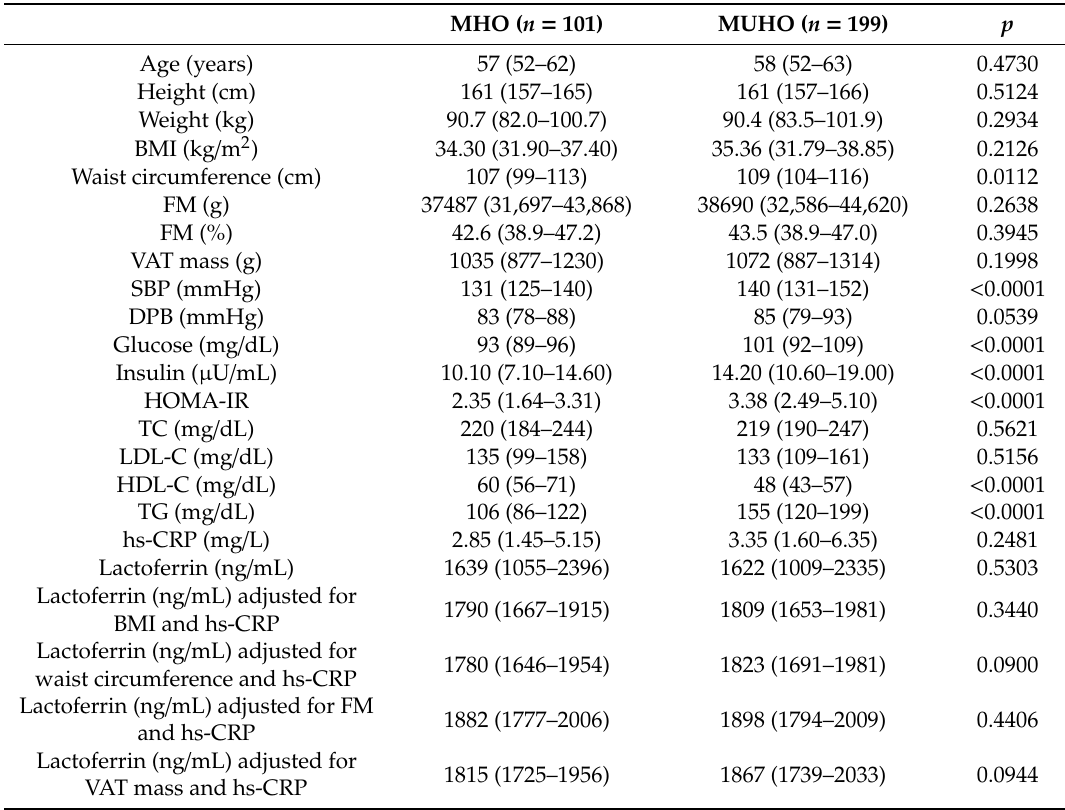
Table 2. Comparison of metabolically healthy obese (MHO) and metabolically unhealthy obese (MUHO)